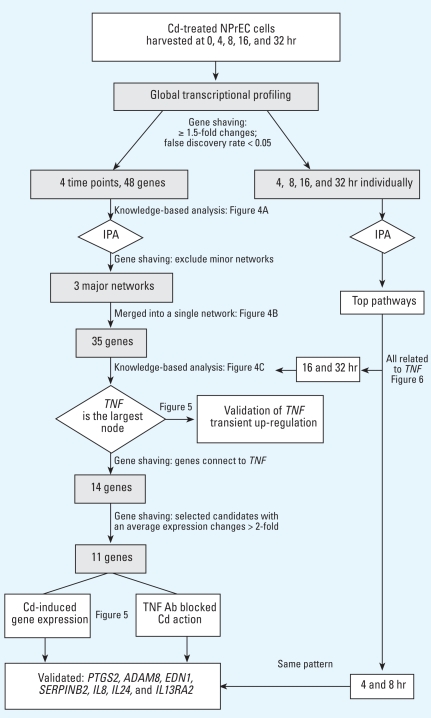
A schematic diagram illustrating the strategies and approaches used in candidate identification, gene shaving, knowledge-based analysis, and validation of a Cd-induced, TNF-regulated transcriptome in NPrEC cells.